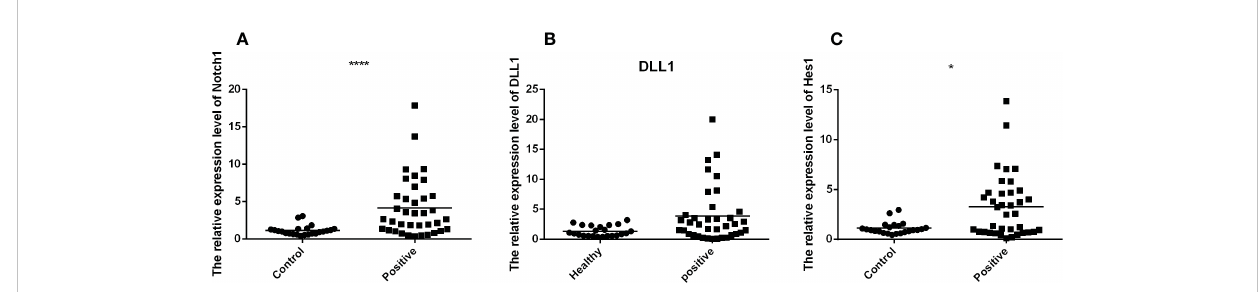
FIGURE 1 The mRNA expression of Notch1, DLL1 and Hes1 of active TB patients (n=37) and healthy controls ( n =23) were detected by RT-QPCR. The data were standardized to b -actin and presented as the mean ± SD of triple independent experiments. Mann-Whitney U test (Wilcoxon rank sum test) was used for statistical analysis. (A – C) respectively showed that the mRNA expression of Notch1, DLL1, and Hes1. * p < 0.05, **** p < 0.0001.